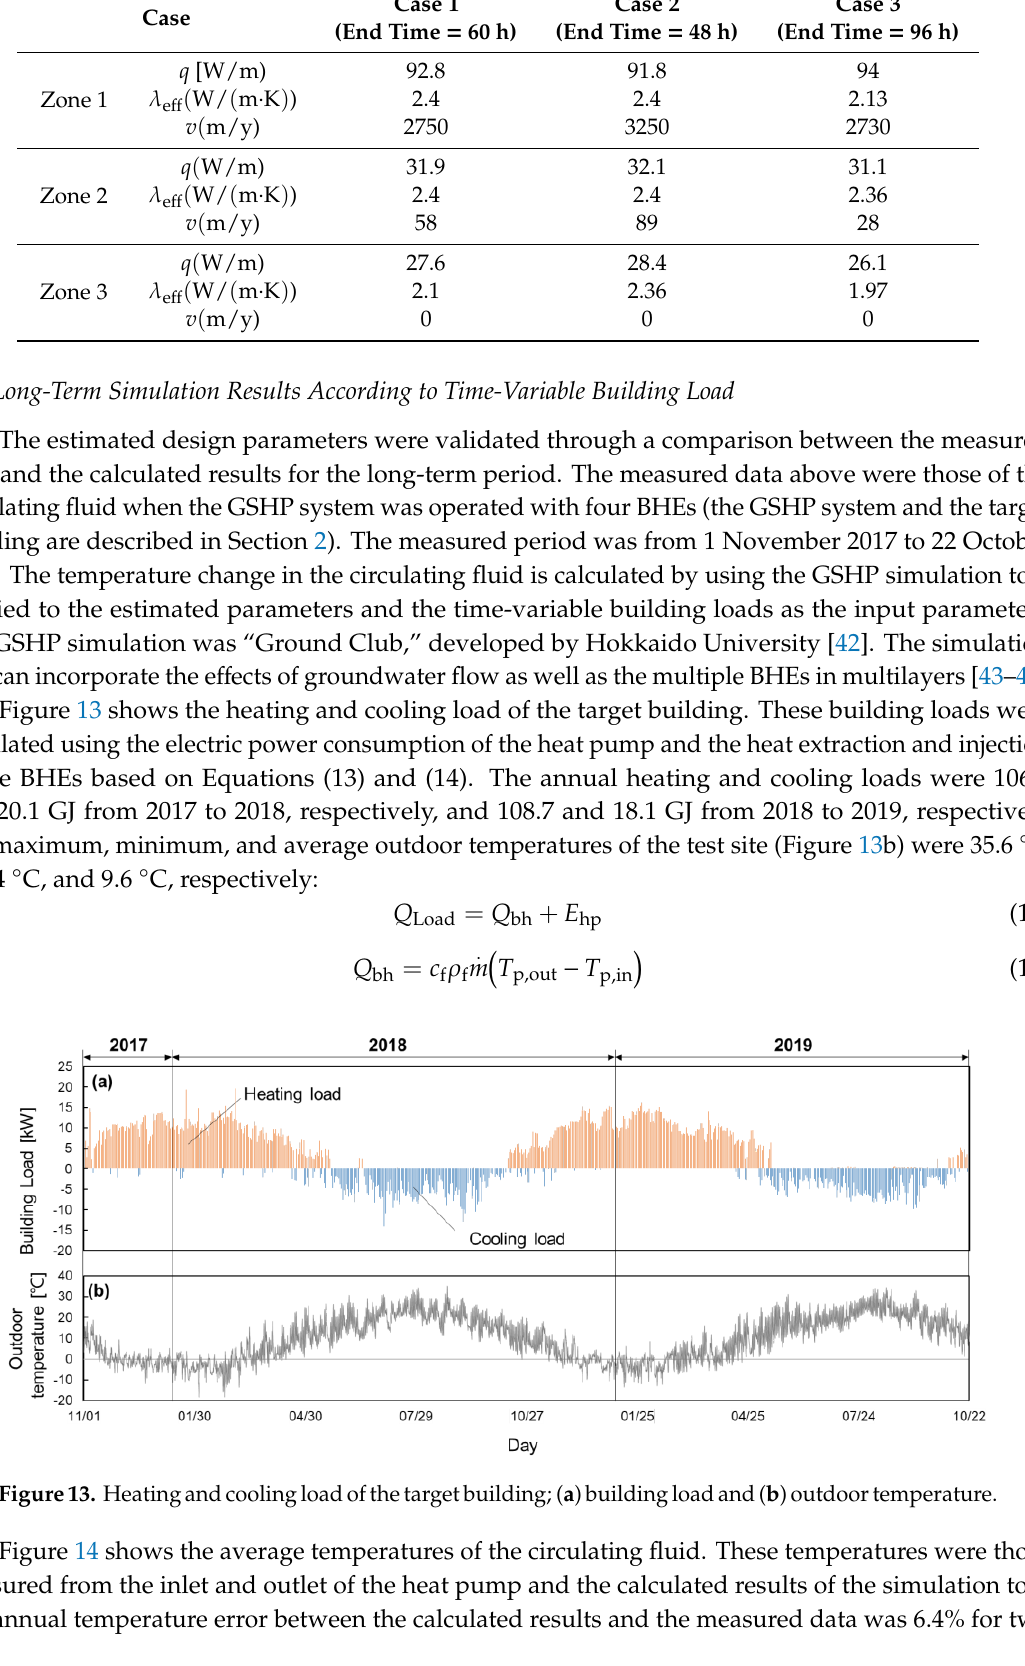
Table 2. Results of the thermal parameter according to the end time.